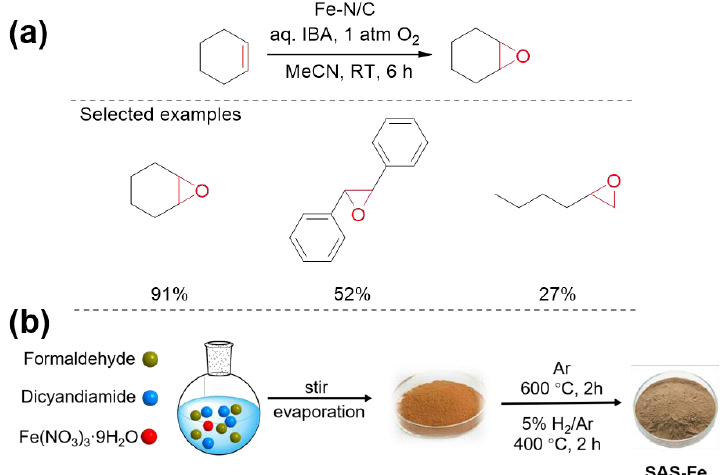
Figure 7. ( a ) Epoxidation of olefines with Fe-N/C catalyst. Reprinted with permission from Ref. [73]. Copyright 2019, Elsevier. ( b ) Schematic diagram for the preparation of SAS-Fe.